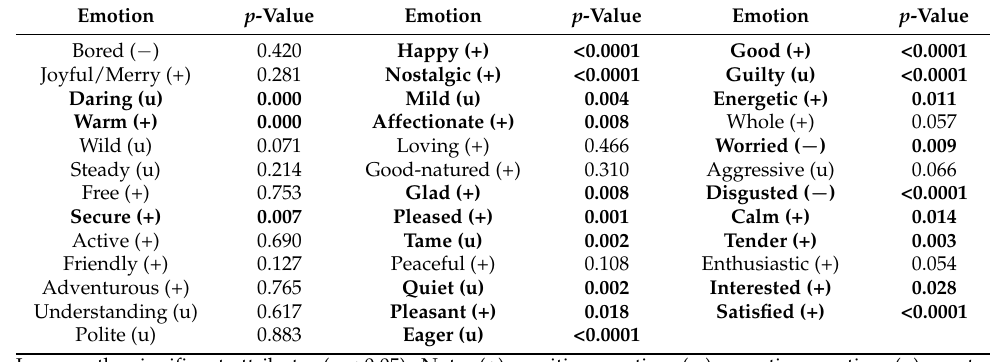
Table 1. Cochran’s Q test for each emotion. Emotion p -Value Emotion p